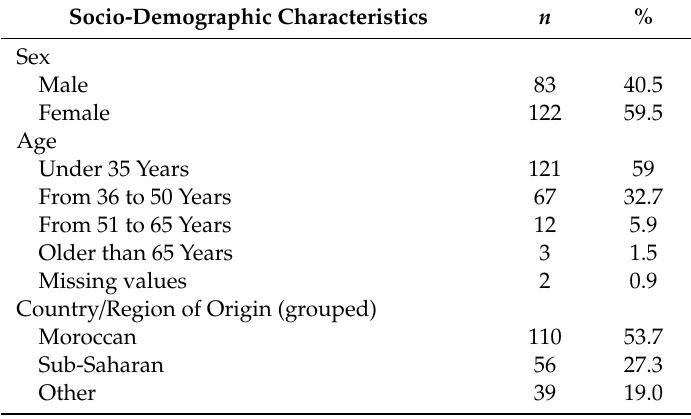
Table 1. Socio-demographic characteristics of the